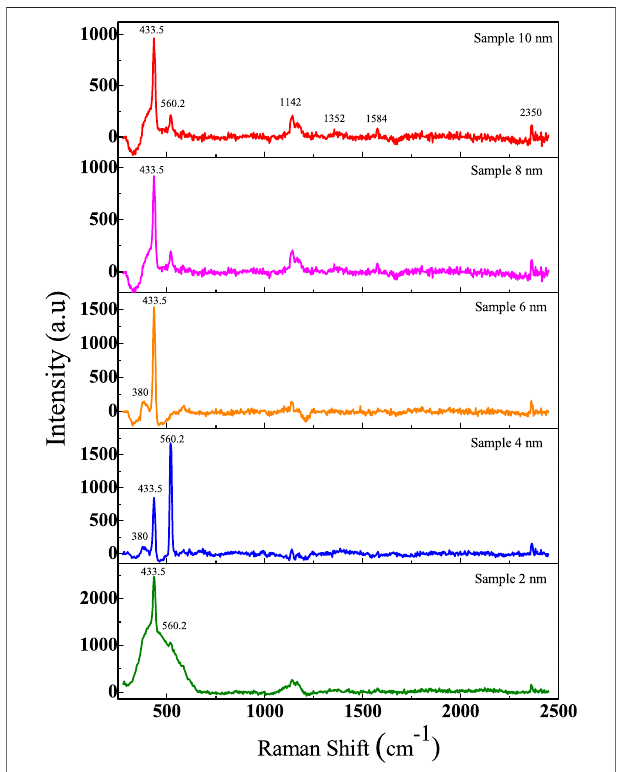
FIGURE 11 | Raman spectra of the annealed Au layer with various thicknesses on the Si substrate.